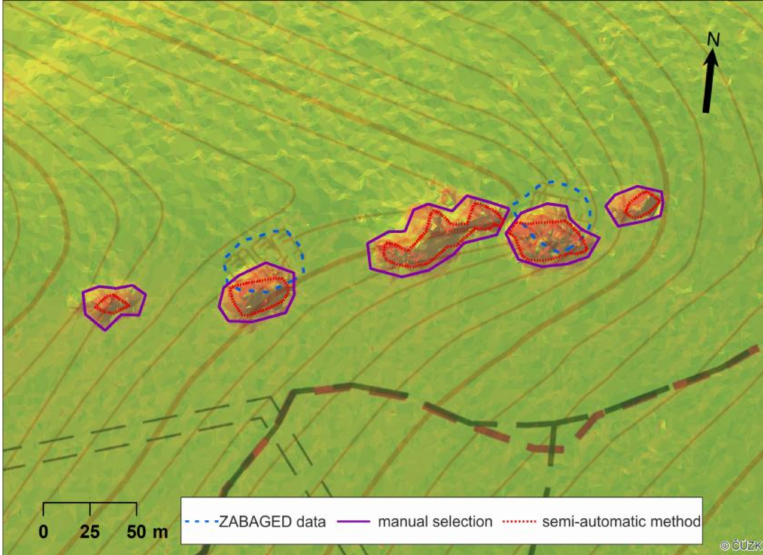
Figure 6. Comparison of rock formation selection based on ZABAGED ® data (blue dashed line), manual selection (purple solid line), and semi-automatic methods (red dotted line) on the base of a shaded trinagle-based slope model of DMR 5G+ and topographic map